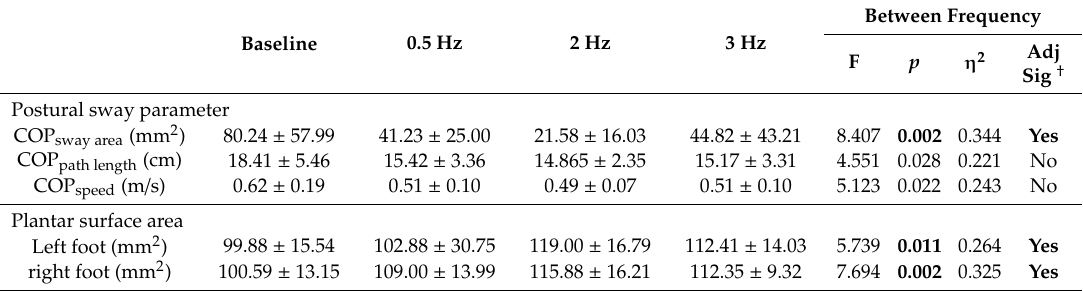
Table 2. Comparisons of postural sway and plantar surface area between baseline and 0.5, 2, and 3 Hz saccadic eye movement.